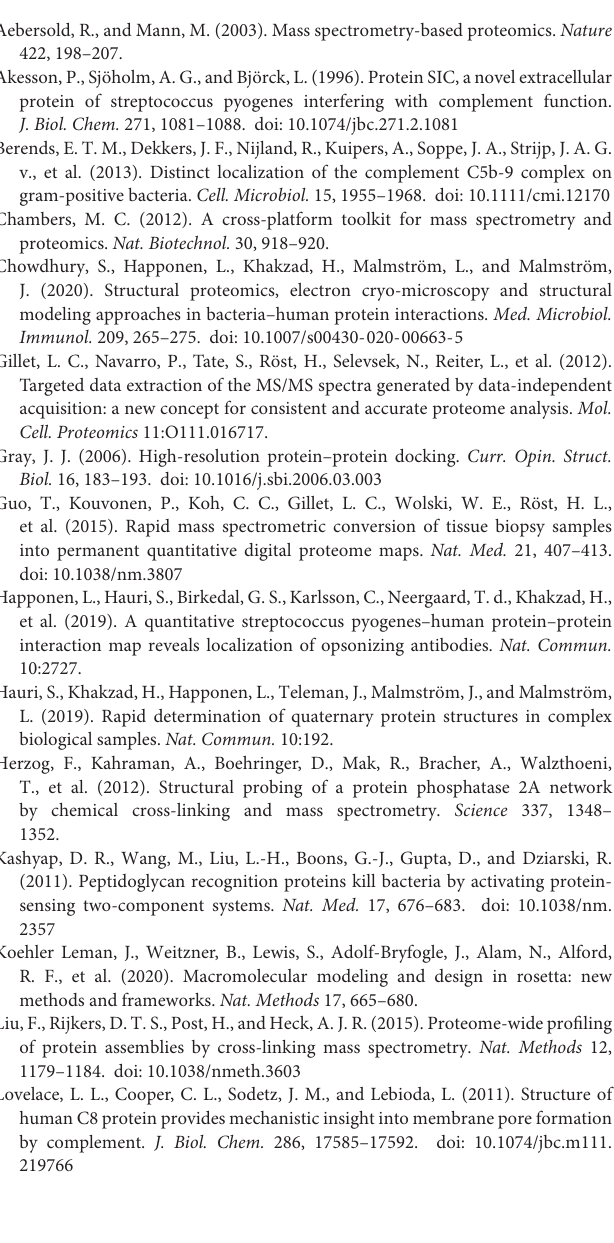
C5b-C6, C6-C7, C7-C8, C8 α -C8 β , C8( α , β )-C9, and C9-C9 interfaces were 16.06, 6.63, 2.16, 0.97, 15.19, and 28.76 Å, respectively. The outliers here are C5b-C6, and C9-C9 interfaces where we see a rotation on C5b and a shift in C9 resulting in high RMSD values (indicated with red